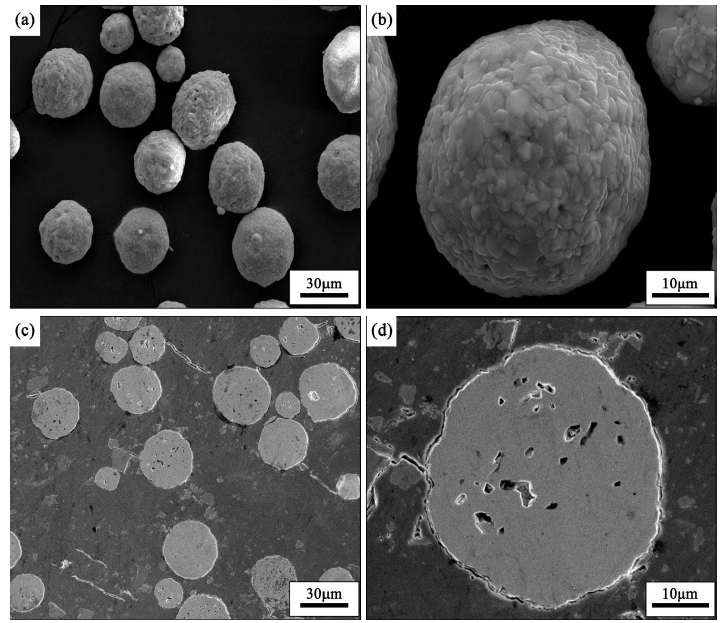
Figure 3. Surface and cross-sectional SEM micrographs of the agglomerated and sintered yttria-stabilized-zirconia (O-AS) powders: ( a ) overall surface morphology; ( b ) surface morphology under high magnification; ( c ) overall cross-sectional morphology; and ( d ) cross-sectional morphology under high magnification. Coatings 2019 , 9 , x FOR PEER REVIEW